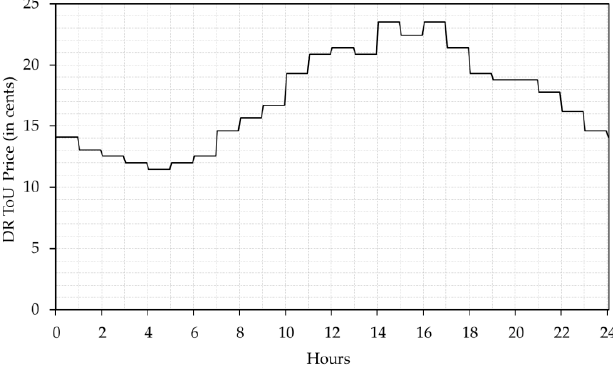
Figure 8. Option F—A ToU price signal for the 24 h of the optimization horizon.